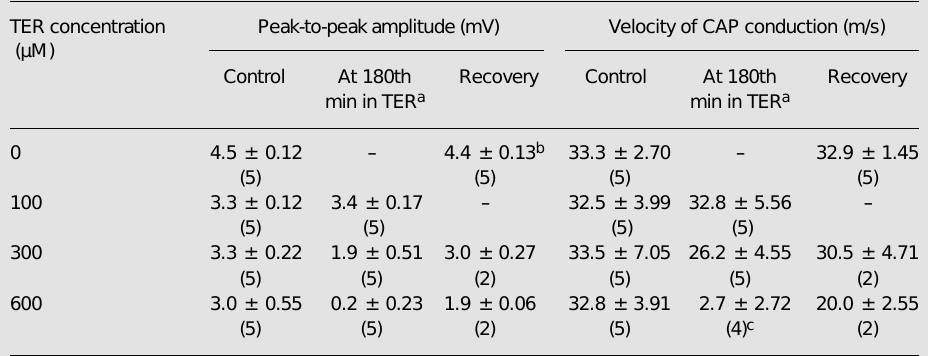
Table 1. Effects of terpineol (TER) on the peak-to-peak amplitude and conduction velocity of the compound action potential (CAP) of the rat sciatic nerve. TER concentration Peak-to-peak amplitude (mV) Velocity of CAP conduction (m/s) (µM) Control At 180th Recovery Control At